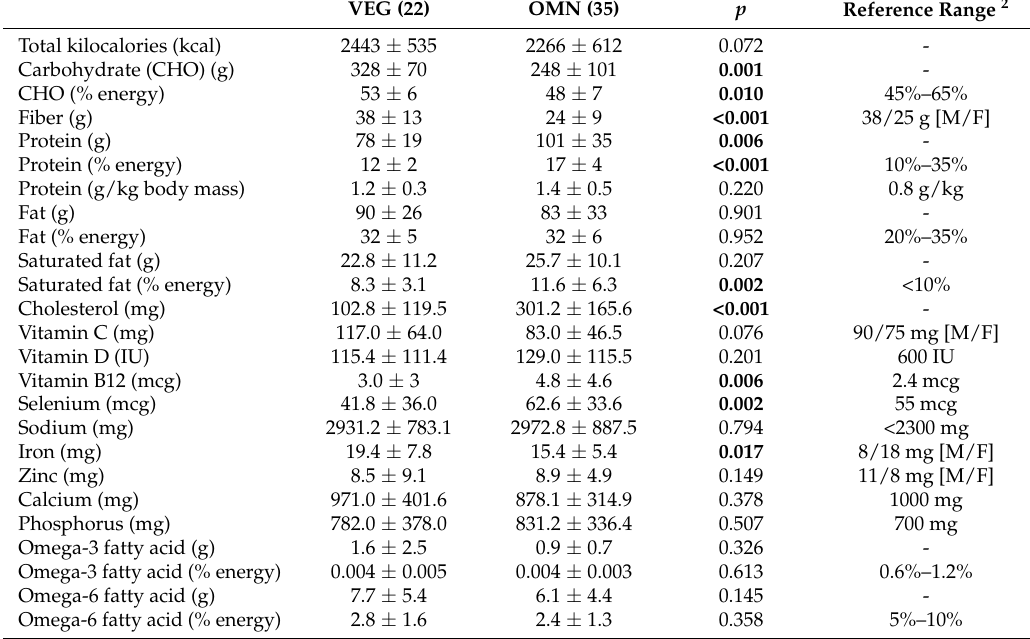
Table 2. Nutrient differences by diet group (vegetarian, VEG; omnivorous, OMN) 1